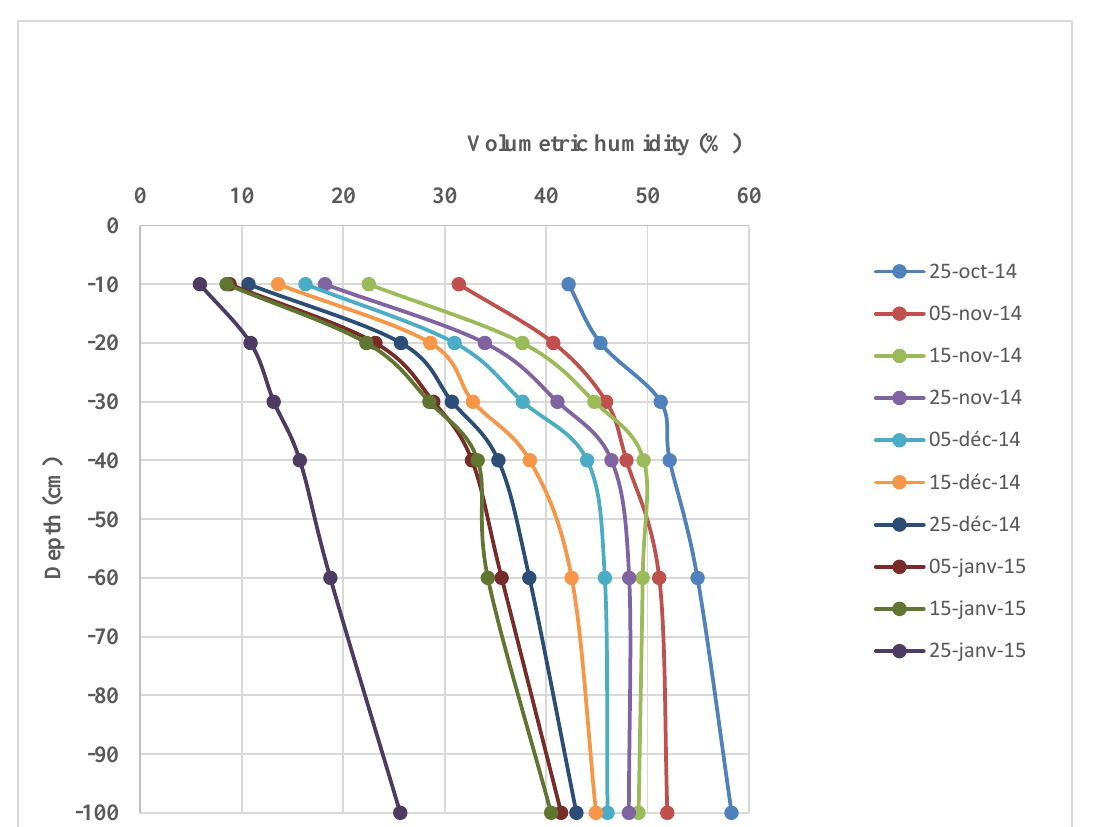
Figure 4. Soil moisture dynamic during the 2014/2015 cropping season in Gory and Y é liman é . The improved varieties have white grains, except for Y é liman é 1, which has a yellow- colored grain. The 1000-g grain weight for the four varieties are 33.4, 29.6, 26.0, and 21.2 for Y é liman é 1, 2, 3, and 4 respectively. The plant heights of the improved varieties are 250, <200, 300, and 300 cm for Y é liman é 1, Y é liman é 2, Y é liman é 3, and Y é liman é 4,